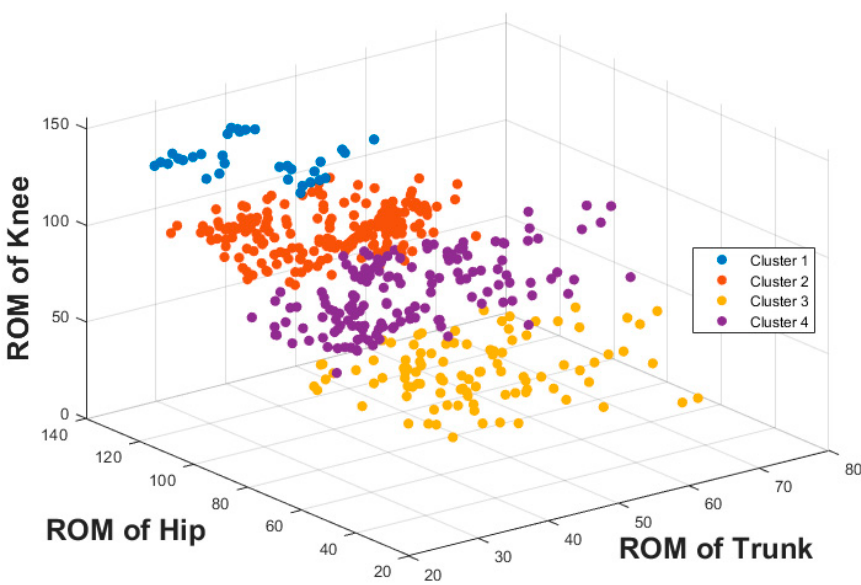
Figure 10. Three-dimensional scatter plot of output of cluster algorithm. Table 5. Descriptive statistics (mean (SD)) of PSEQ, and pain level for each cluster.